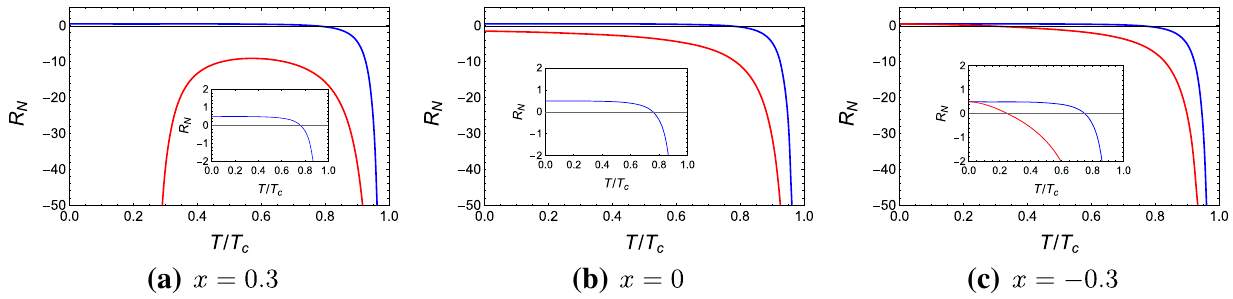
Fig. 7 Thebehavior of thenormalizedscalarcurvature alongthecoex- istence curvature R N with x = 0 . 3, 0 and − 0 . 3. The solid blue curve representsasaturatedsmallblackholeandtheredsolidcurverepresents saturated large black hole. The solid red curve in a tends to be negative